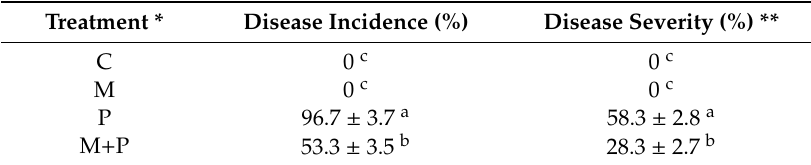
Table 3. Disease assessment of sunflower plants in response to infection with R. solani and / or colonization with R. irregularis (28 days after inoculation with R. solani ).